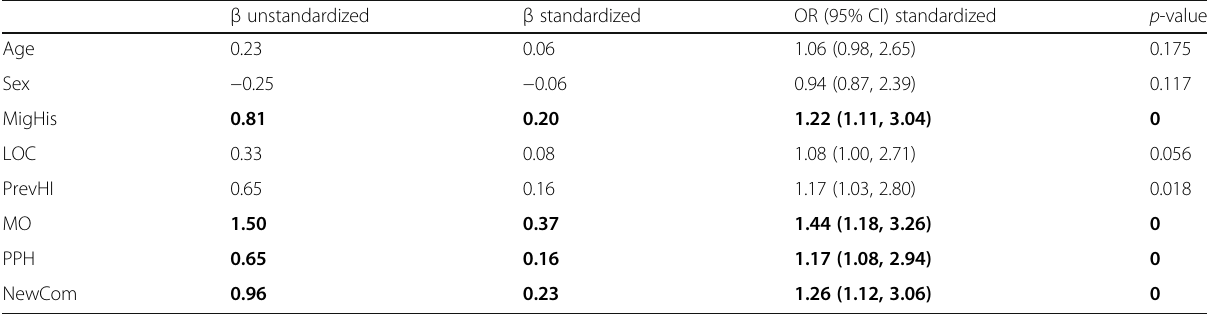
Table 4 Logistic regression